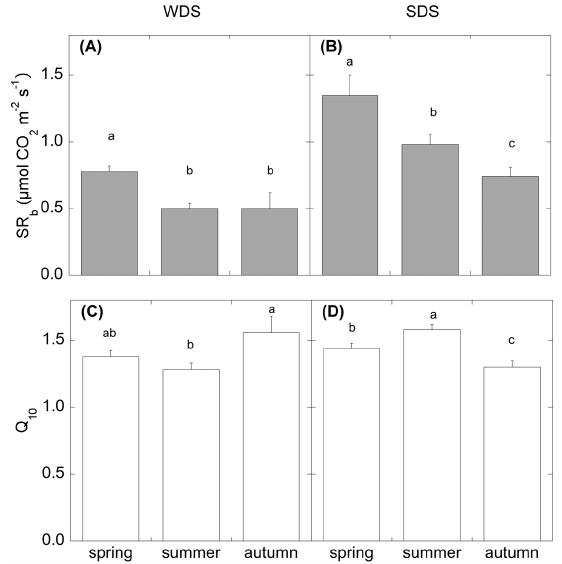
Figure 3. Heterotrophic soil basal respiration SR b and temperature sensitivity Q 10 calculated by fitting the exponential equation SR h = a*exp(k*Ts). SR b = a for Ts = 0 °C, Q 10 = exp(10*k) in winter deciduous (WDS, left panels, A , C ) and summer deciduous (SDS, right panels, B , D ) sites. Lowercase letters show significant seasonal differences ( p < 0.05) in each site for each parameter (±s.e., n =